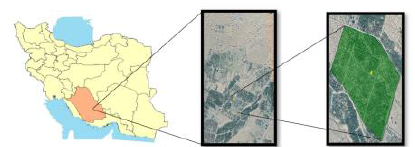
Figure 4. Spectral bands and configuration of the Red Edge camera (Mica sense Inc 2017)